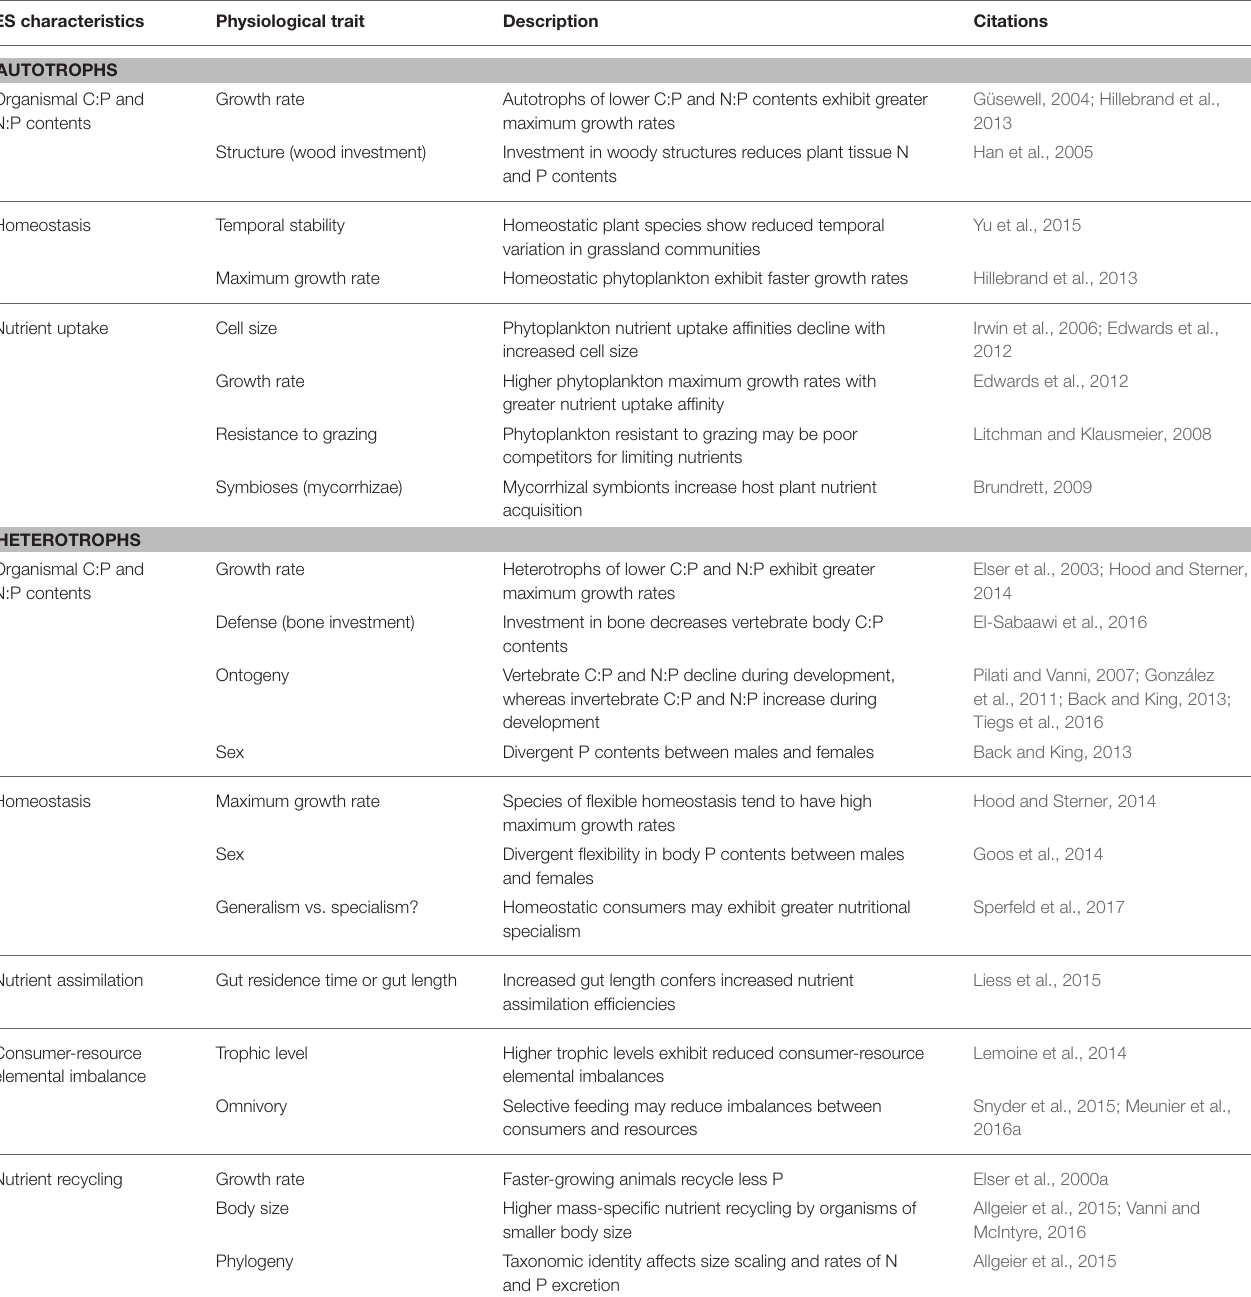
TABLE 1 | Relationships between elemental stoichiometry characteristics and physiological traits among autotrophs and heterotrophs, with abbreviated description of the linkage and associated citations. ES